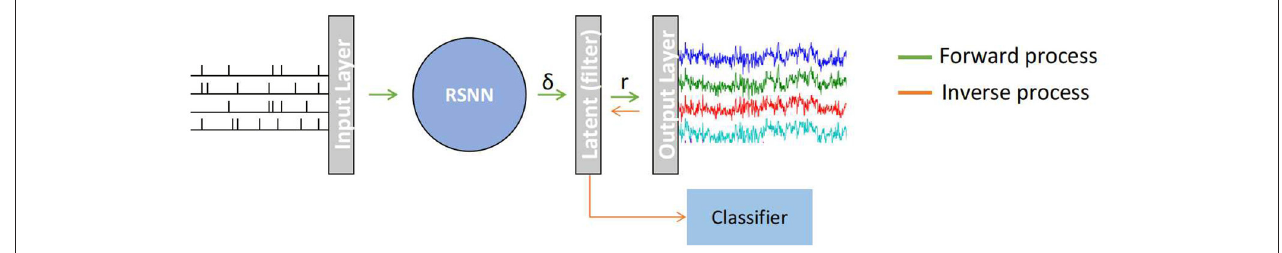
FIGURE 1 | A recurrent spiking neural network (RSNN) model that maps a random input spike-train from Input Layer to a multi-channel EEG signal in the Output Layer . The spike trains ( δ ) from RSNN are processed in the latent layer to continuous signal r using a double exponential synaptic filer before converting to an EEG signal. This model works in two stages: (1) Forward process in which SNN generates template EEG signal, (2) Inverse process in which the non-template signal are transformed to spike-representation for